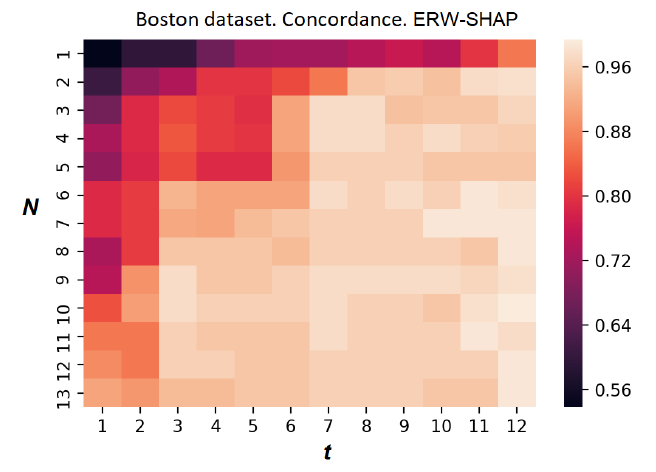
Figure 16. The heatmap illustrating the relationship between computation times of SHAP and ER-SHAP for the Boston Housing dataset.